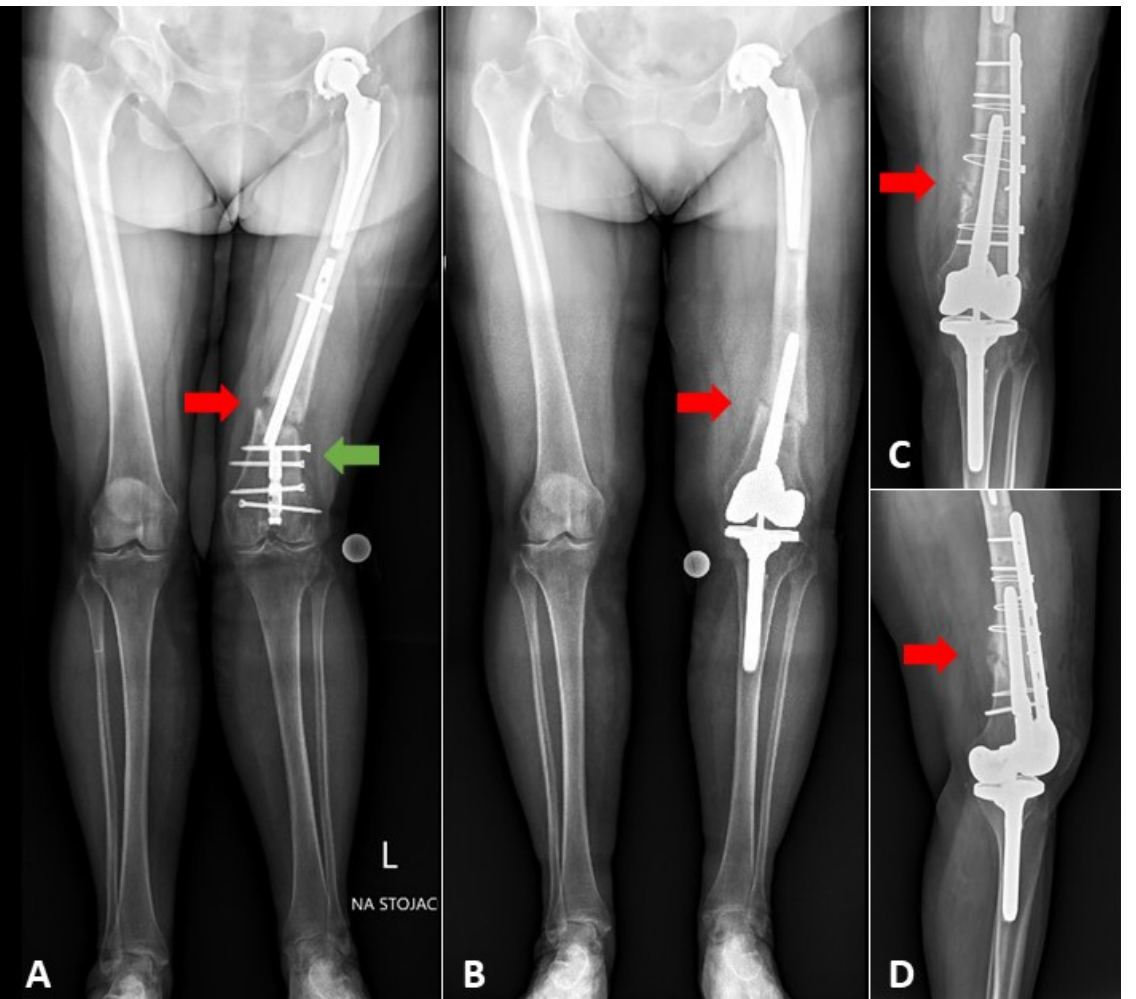
Figure 3. ( A ) AP long-standing radiograph of the patient with the fracture of 1/3 distal part of the femoral shaft, with the broken retrograde femoral nail (green arrow), and knee osteoarthritis; ( B ) long-standing radiograph performed nine months after the one-stage TKA with long-stem extension. Bone union was not achieved due to insufficient stability of fracture causing excessively short (64 mm from the tip of stem to fracture level) and undersized stem (13 mm stem diameter filling 68% of medullary canal in the narrowest point). Shorter femoral stem was used due to the presence of hip prosthesis ipsilaterally. ( C ) AP and ( D ) lateral radiographs after re-stabilization with the additional plate fixation. Red arrows indicate fracture level.